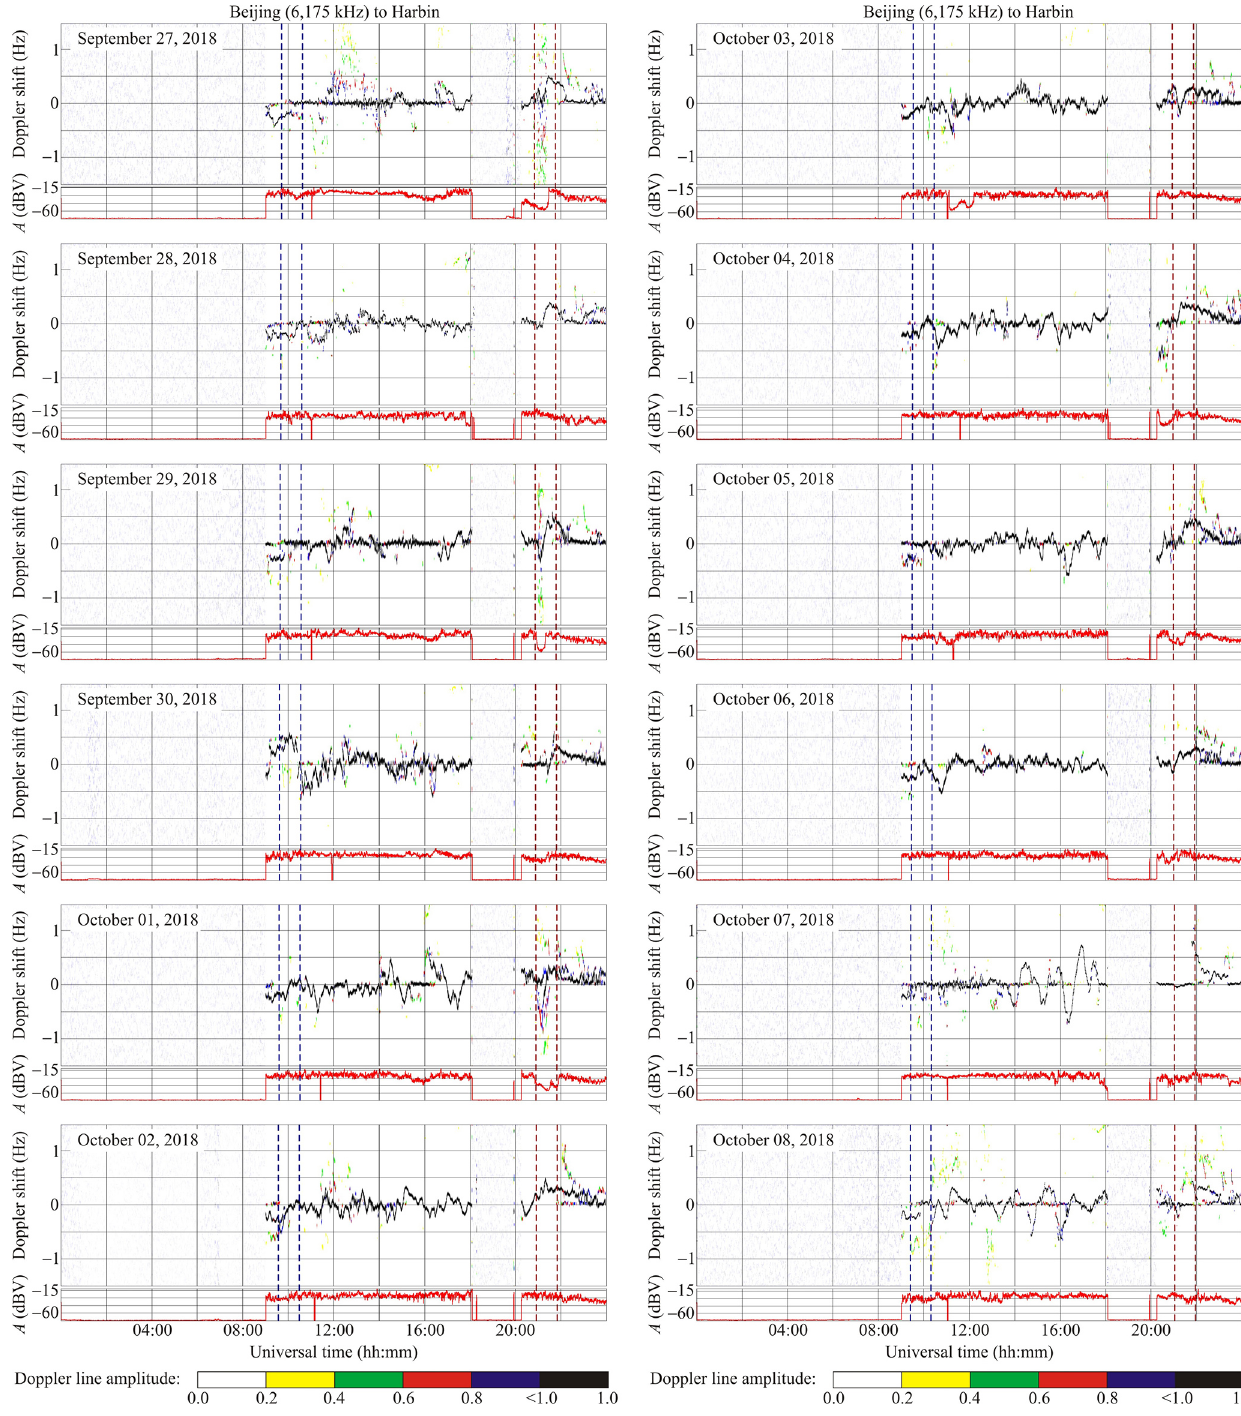
Figure 9. Same as in Fig. 6 but for the Beijing to Harbin radio-wave propagation path at 6175kHz for the 27 September–2 October and 3–8 October 2018